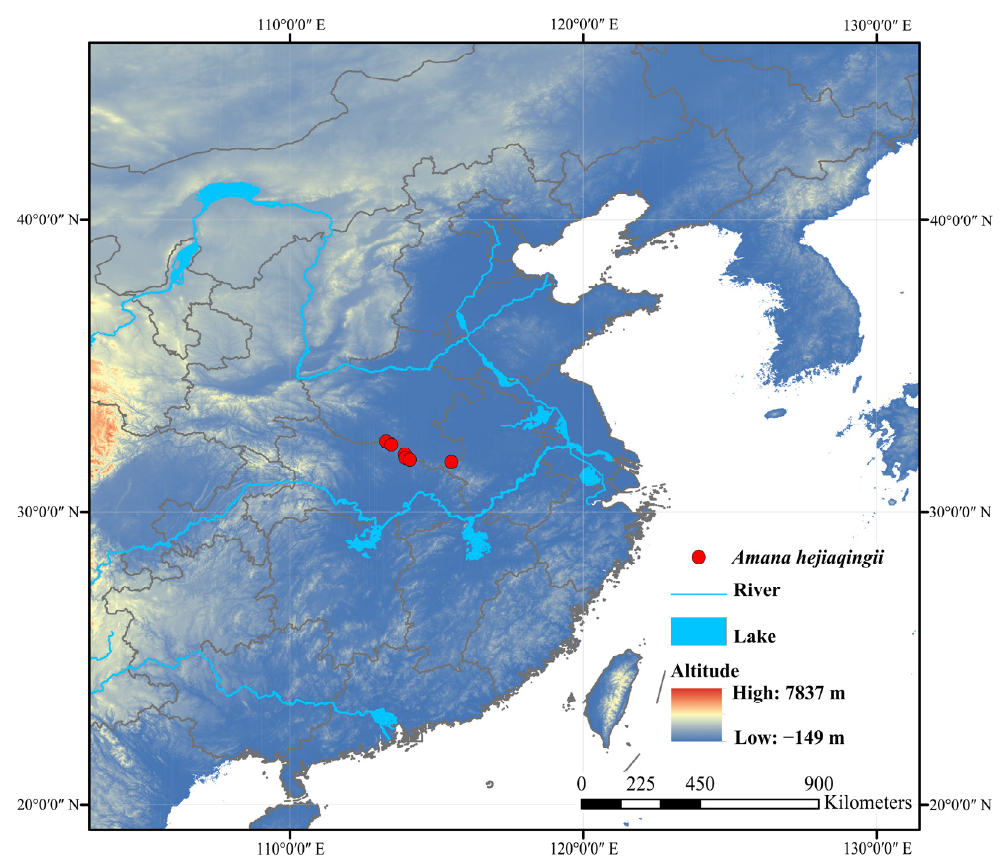
Figure 1. Distribution of Amana hejiaqingii . The red dots represent the known populations of Amana hejiaqingii .